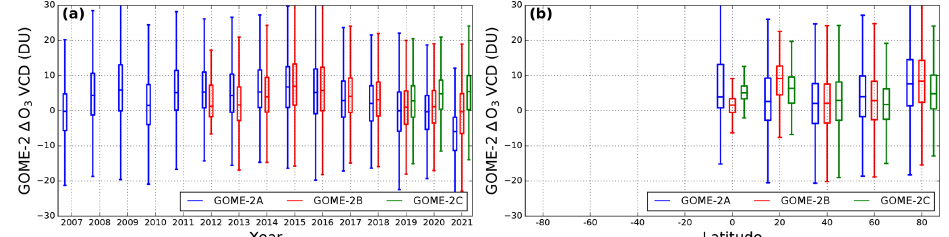
Figure 13. Comparison of total column O 3 between ground-based Brewer instruments and GOME-2 observations. Data are sorted by year in panel (a) and latitude band in panel (b)